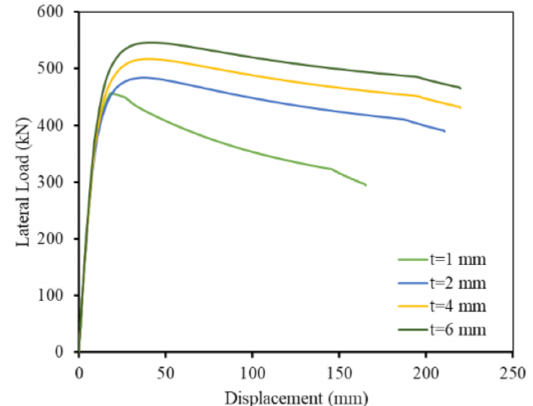
Figure 24. Lateral load-displacement curves according to inner tube thickness (S-C